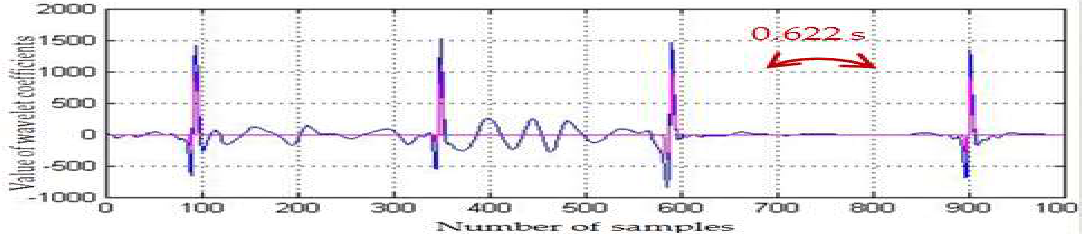
Figure 6. infant6_ecgm (hour 1.31.36–1.31.38 of recording).